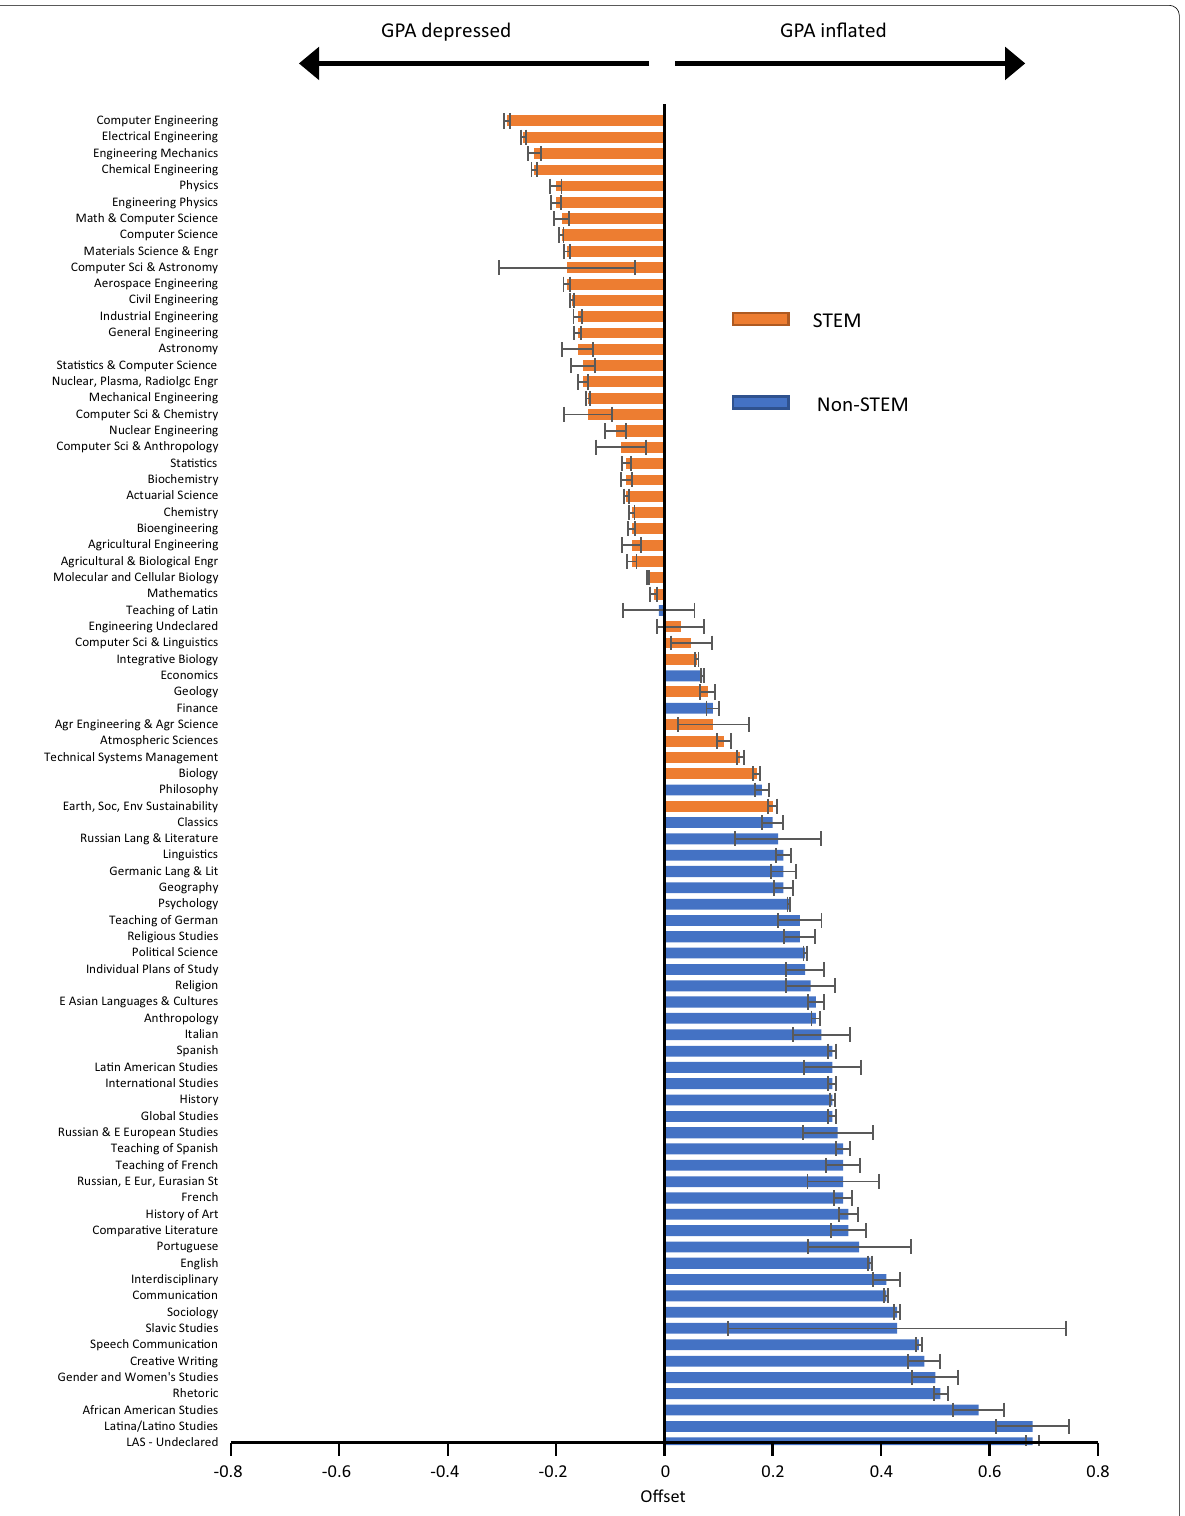
Fig. 3 Average GPA offset for students in each major. A grade difference of 1.0 is equivalent to a letter grade. Error bars display standard error of the mean ( 1 S.E.). The differences in the S.E. are largely determined by differences in the number of students in each program of ±